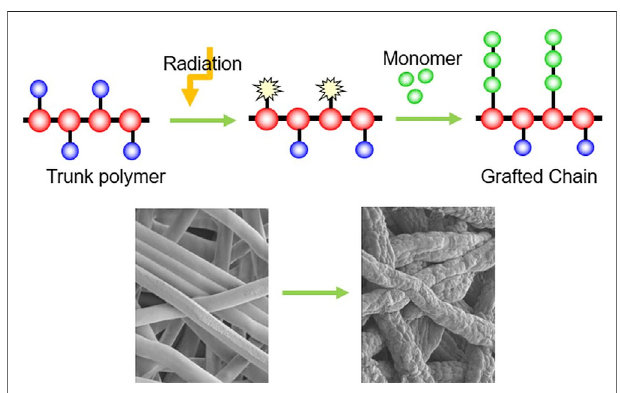
FIGURE 2 | Simpli fi ed structure of radiation grafted